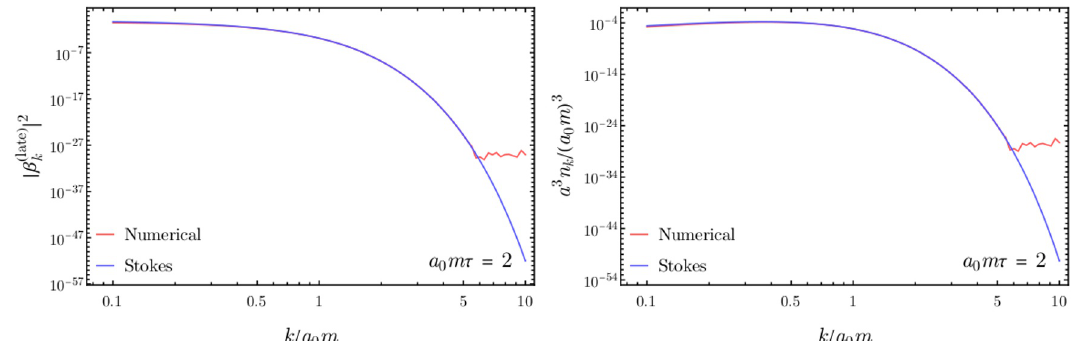
Figure 5 . A comparison of GPP calculations via direct numerical integration of the mode equations (red) and analytical analysis with Stokes phenomenon (blue). The left panel shows the squared Bogoliubov coefficient | β (late) | 2 , the right panel shows the comoving particle number density (per d.o.f) k spectrum a 3 n k / ( a 0 m ) 3 = ( k/a 0 m ) 3 | β (late) | 2 / 2 π 2 , and the horizontal axis the comoving wavenumber k k/a 0 m . We show a model with a 0 mτ = 2 ; other choices of the particle’s mass m or duration of non-adiabaticity τ lead to qualitatively similar results. Both the numerical solution and the Stokes solution agree well over a wide range of wavenumbers. At low k the solutions differ by a factor of ≈ 2 as the adiabatic approximation becomes less reliable, and at high k the numerical solution behaves poorly due to issues with numerical